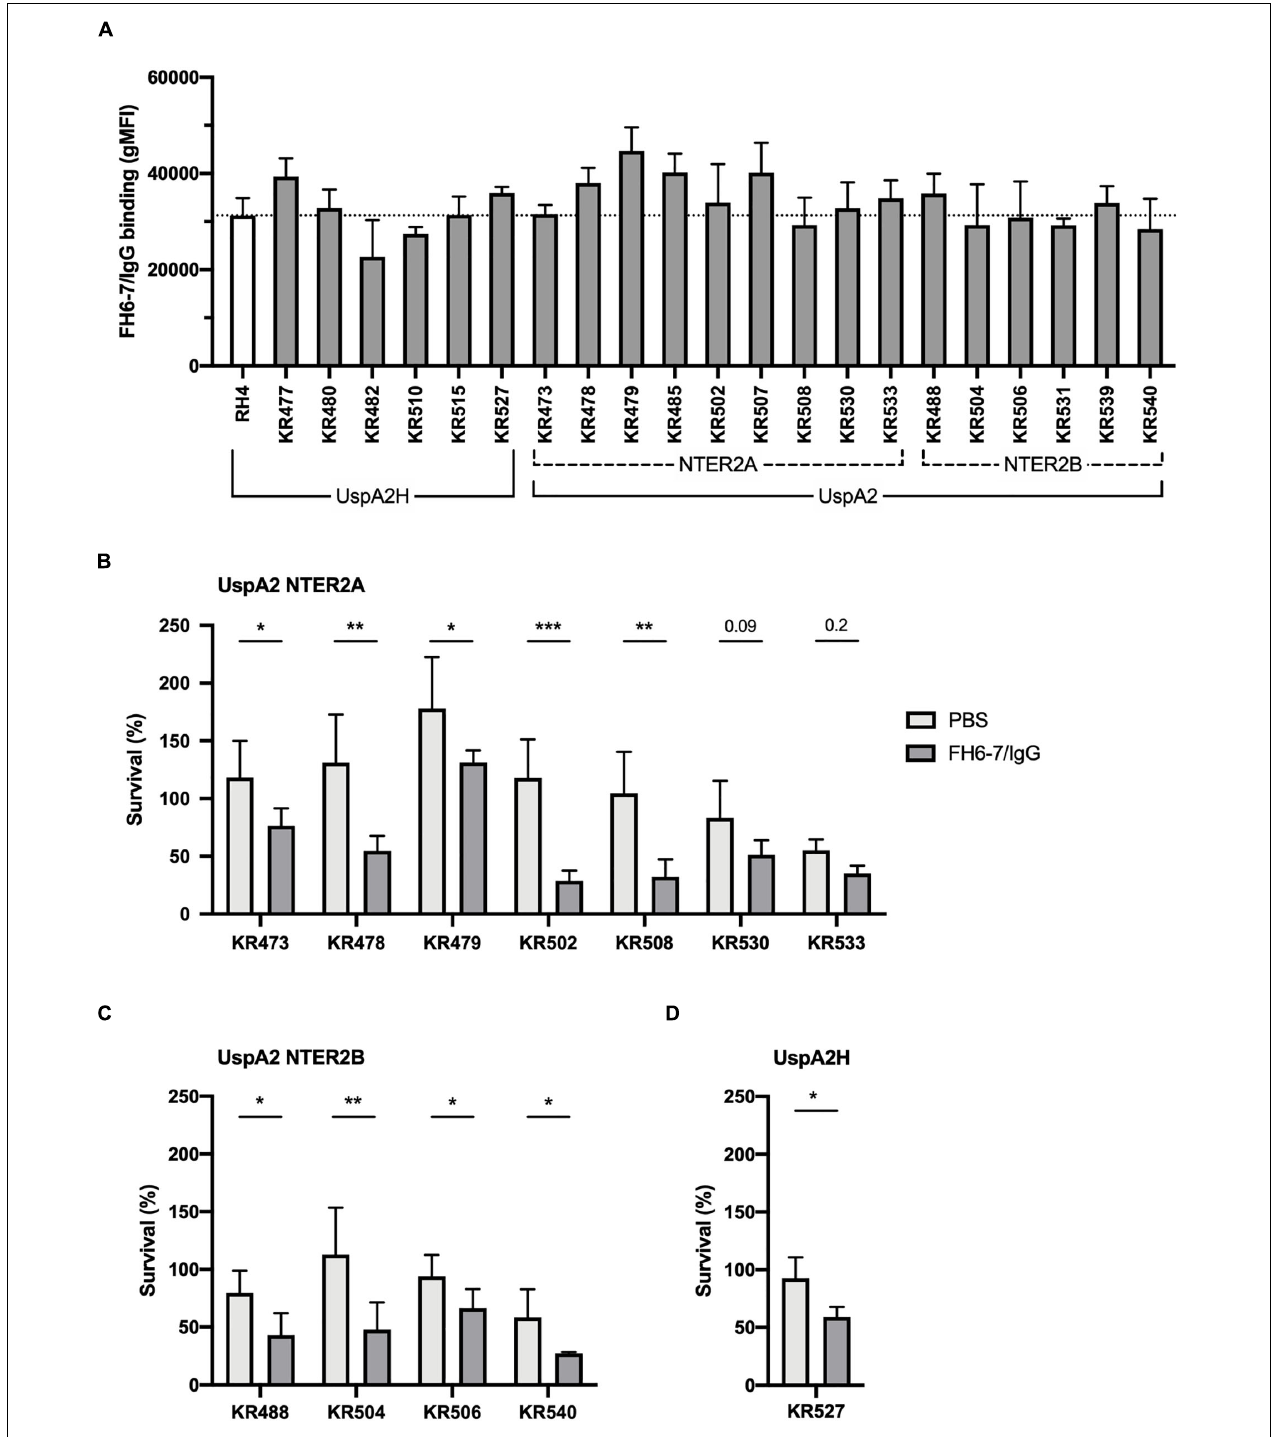
FIGURE 6 | FH6-7/IgG binds to and increases serum killing of a large majority of M. catarrhalis clinical isolates. (A) 21 clinical isolates and the laboratory strain RH4 were tested for FH6-7/IgG binding by flow cytometry. In the absence of FH6-7/IgG, bacteria incubated with detection antibody had a similar gMFI for all isolates (average 151, standard deviation 45). (B–D) Twelve clinical isolates were treated with 50 µ g/ml of FH6-7/IgG or PBS, at the same time as 15% NHS, and their survival after 30 min was assessed by plating bacteria and counting remaining colony forming-units (CFU). The remaining nine isolates were not included because their survival in serum in the absence of fusion protein was less than 5%. (B) UspA2 NTER2A strains, (C) UspA2 NTER2B strains, (D) UspA2H strains. Mean ( ± SD) from three (A–C) or four (D) independent experiments are shown. Statistical significance of differences was calculated using two-way ANOVA with Holm–Sidak’s post-test; * p < 0.05; ** p < 0.01; *** p <